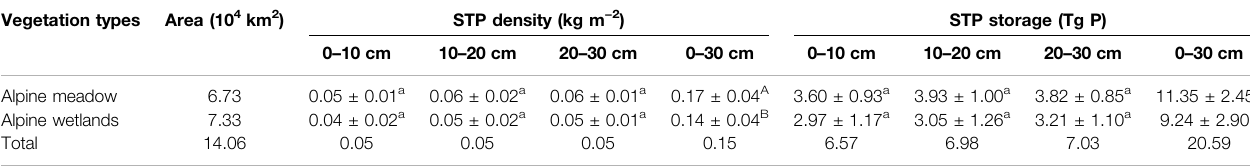
TABLE 2 | Soil total phosphorus (STP) density and storage in alpine meadow and alpine wetlands in the Three Rivers Source Region. Different lowercase letters indicate a signi fi cantdifferenceinSTPdensityandSTPstorageamongsoillayersineachvegetationtype,whiledifferentcapitallettersindicateasigni fi cantdifferenceinSTPdensity and STP storage to 0 – 30 cm soil depth between two vegetation types.